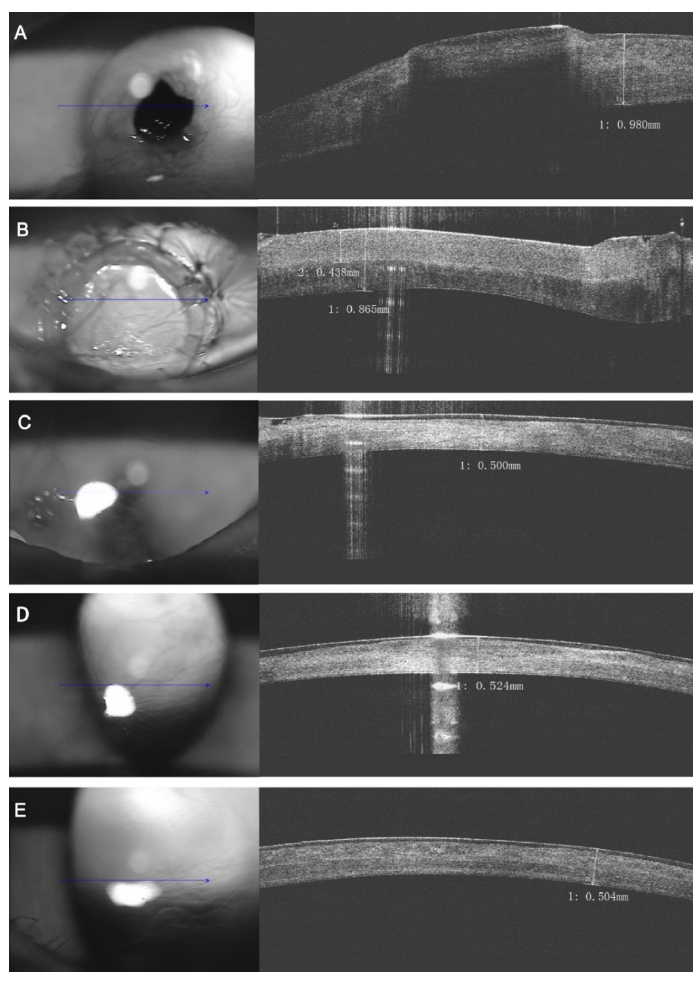
Figure 6. The same patient as Figure 1. Optical coherence tomography (OCT) upon the eye. ( A ) Preop- erative image; ( B ) Immediate examination after acellular bioengineering cornea lamellar keratoplasty: The fine interface between the graft and the recipient side; ( C ) Three months post-operatively: No obvious transition between the graft and the recipient side, both of which were stable; ( D ) Six months post-operatively: The whole cornea was showed highly integral and uniform; ( E ) Twelve months post-operatively: The alignment of the collagen fibers in the whole cornea was integrated and restored. (Blue arrows: corneal L-Scan